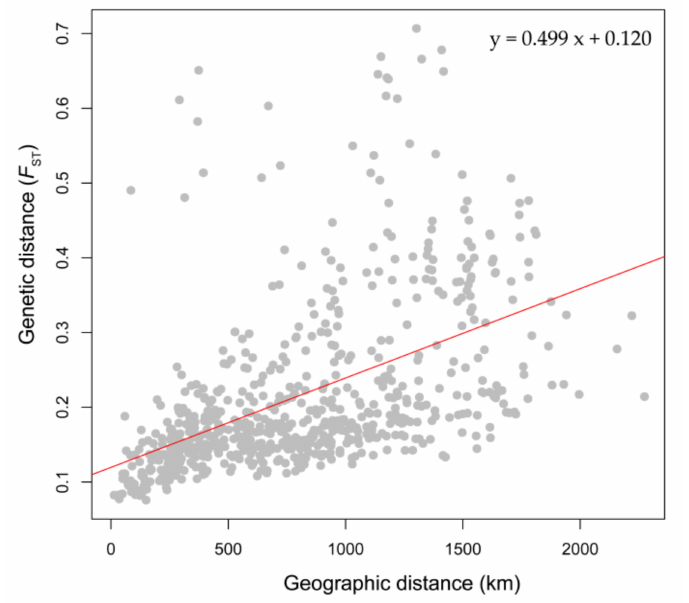
Figure 6. Isolation by distance (IBD) analysis: correlation between genetic distance and geographical distance among 37 populations ( r = 0.499, p <